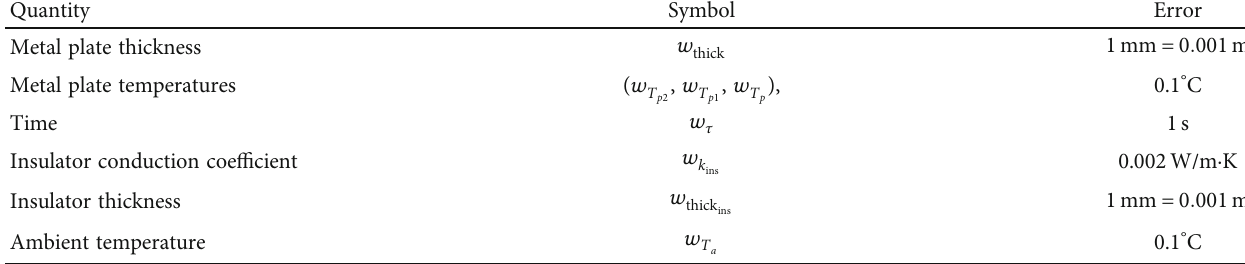
Table 2: Instrumentation errors.